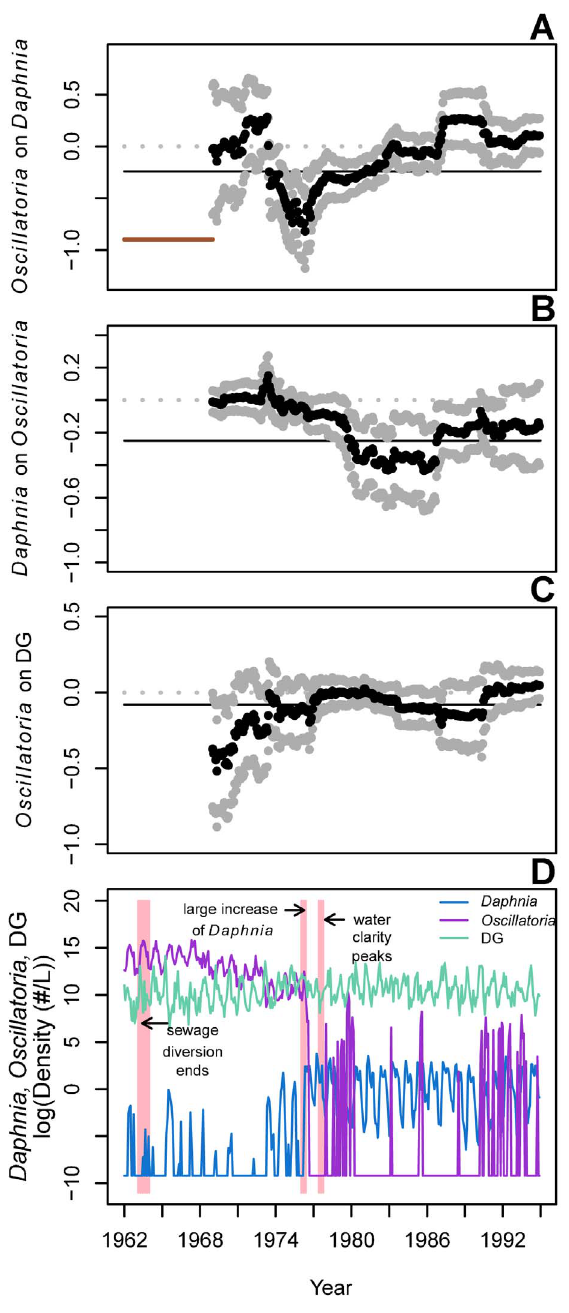
Figure 1. Shifting impacts of Oscillatoria on the Lake Washing- ton plankton community. Effects of Oscillatoria on Daphnia (A); Daphnia on Oscillatoria (B); and Oscillatoria on diatoms/green algae, DG, (C) estimated by a mwMAR model using an 84-timestep window (indicated by solid red horizontal line shown in A). The mwMAR- estimated effect of Oscillatoria on NDC was non-significant. Estimates are shown with 95% upper and lower CIs. Grey dotted lines indicate a neutral interaction; solid black lines indicate the average interaction across the full time series, as estimated by a traditional MAR model. The raw time-series data are given in (D), with years of significant known changes shown in shaded vertical bars. All results are presented at the end year of the moving